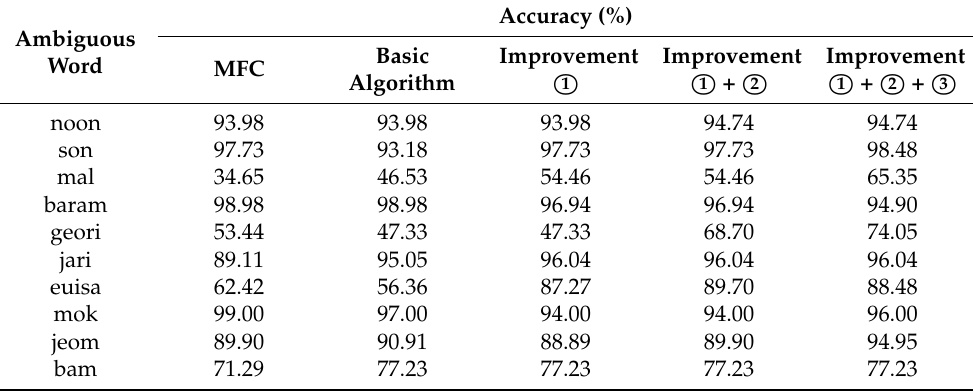
Table 7. Performance evaluation of the proposed method.